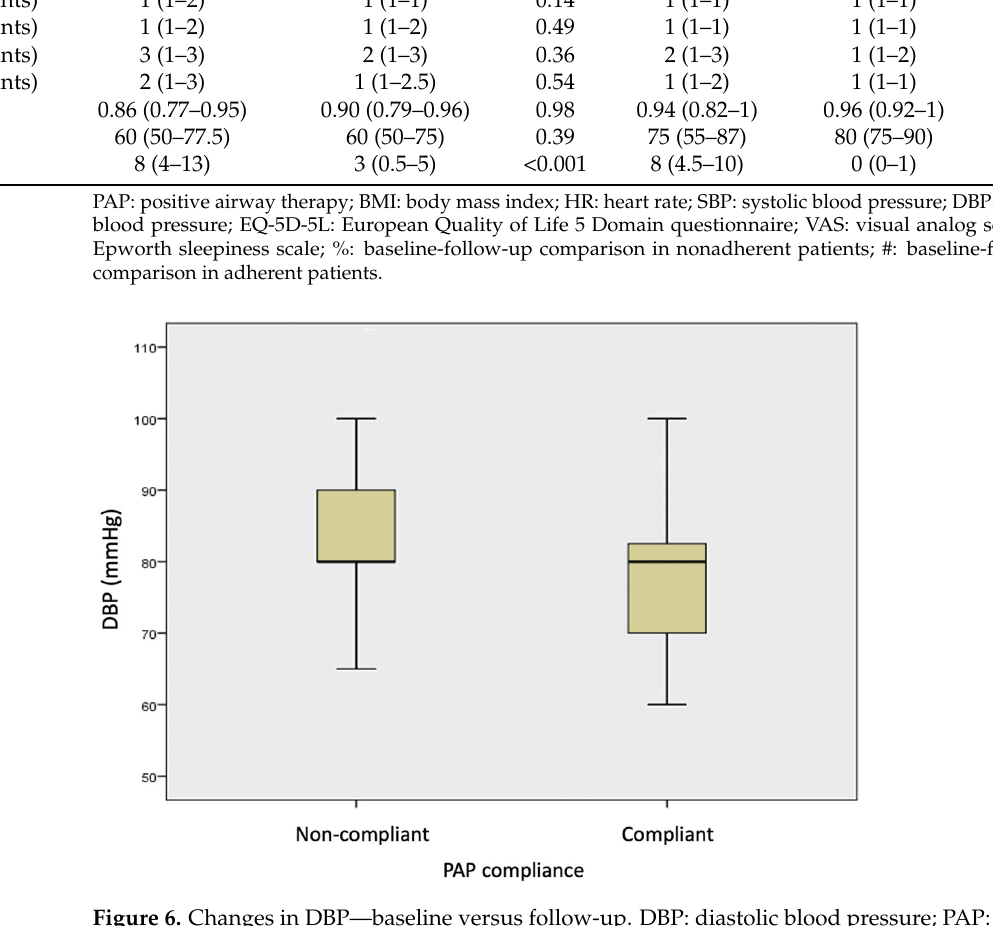
Figure 7. Changes in ESS—baseline versus follow-up. ESS: Epworth sleep score results; PAP: posi- tive airway pressure. PAP discontinuation was associated with higher GAD-7 scores ( p = 0.003). The asso- ciation remained signi fi cant for items 1, 3, 4 and 6 (feeling nervous/anxious/on edge, wor- rying too much about di ff erent things, trouble relaxing and becoming easily annoyed/ir- ritable, respectively) (Table 3). Anxiety was more prevalent in PAP-nonadherent (31.03%) versus -adherent (10.52%) patients ( p < 0.001). PAP nonadherence was signi fi cantly associated with overall higher PHQ9 scores ( p = 0.007). The association remained signi fi cant for the self-reported sleep di ffi culties ( p = 0.003), lack of energy/tiredness ( p = 0.002) and appetite disruptions ( p = 0.018) items (Table 3). Depression was more prevalent in PAP-nonadherent (37.93%) versus -adherent (5.26%) patients ( p < 0.001). The total PA, PA per each analyzed domain (work, leisure, domestic and transport) and REAP total score and per each item were similar in the 2 subgroups ( p > 0.05) (Table